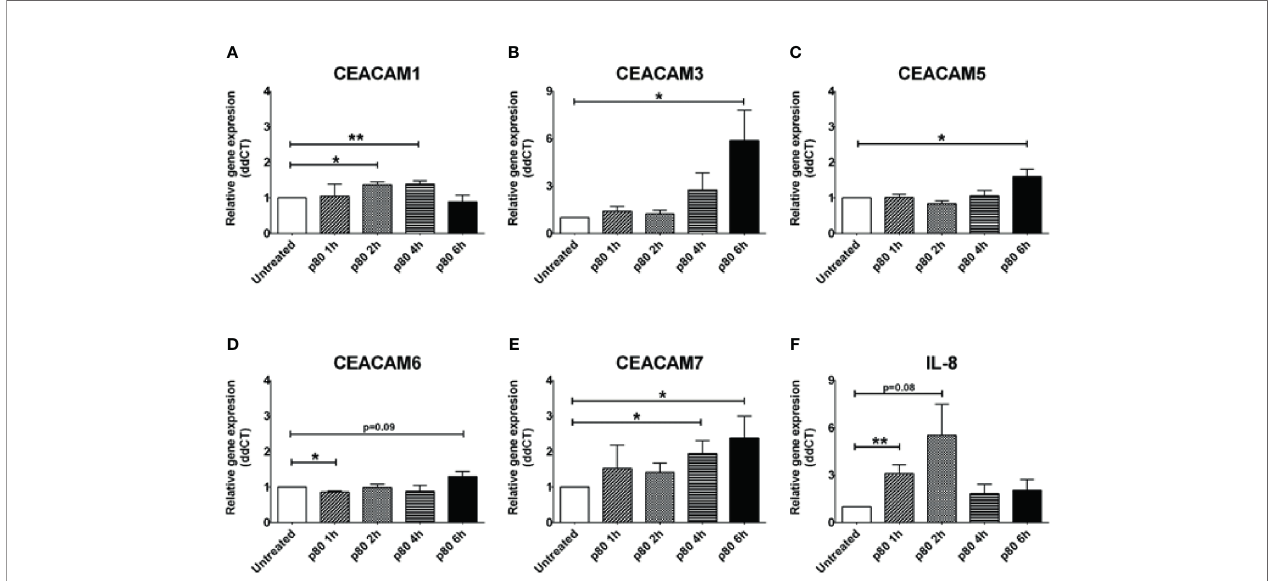
FIGURE 3 | Relative gene expression pro fi le in HT29 cells treated with 0.25% polysorbate 80 (p80) for 1, 2, 4, and 6 h for analysis on gene expression of (A) CEACAM1, (B) CEACAM3, (C) CEACAM5, (D) CEACAM6, (E) CEACAM7, (F) IL-8 as determined by RT-qPCR. Graphs are representative of two to four independent experiments with pooled triplicate samples and qRT-PCR assay performed in duplicates. b -actin was used as a housekeeping gene, and results are expressed as fold change. A Student t-test was used to analyze gene expression data. *P < 0.05, **P < 0.01 when compared to untreated cells.